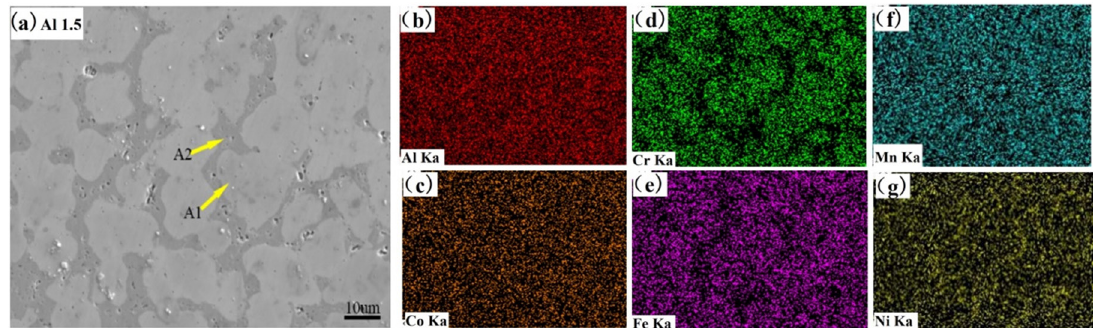
Figure 5. Elementenl distribution of Al1.5 cladding